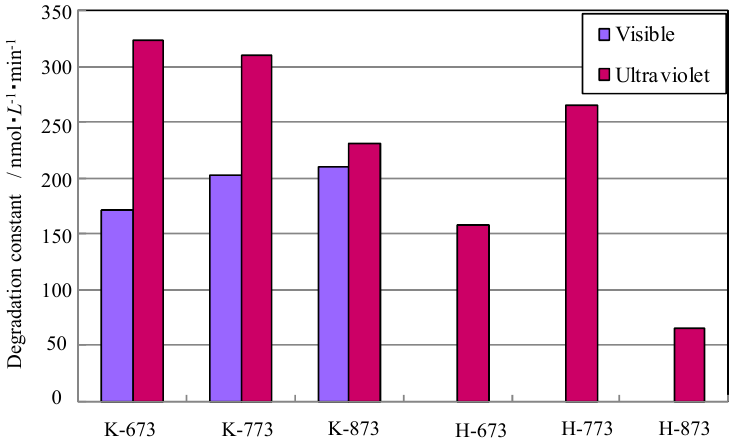
Figure 57. Degradation rate constant of the samples.